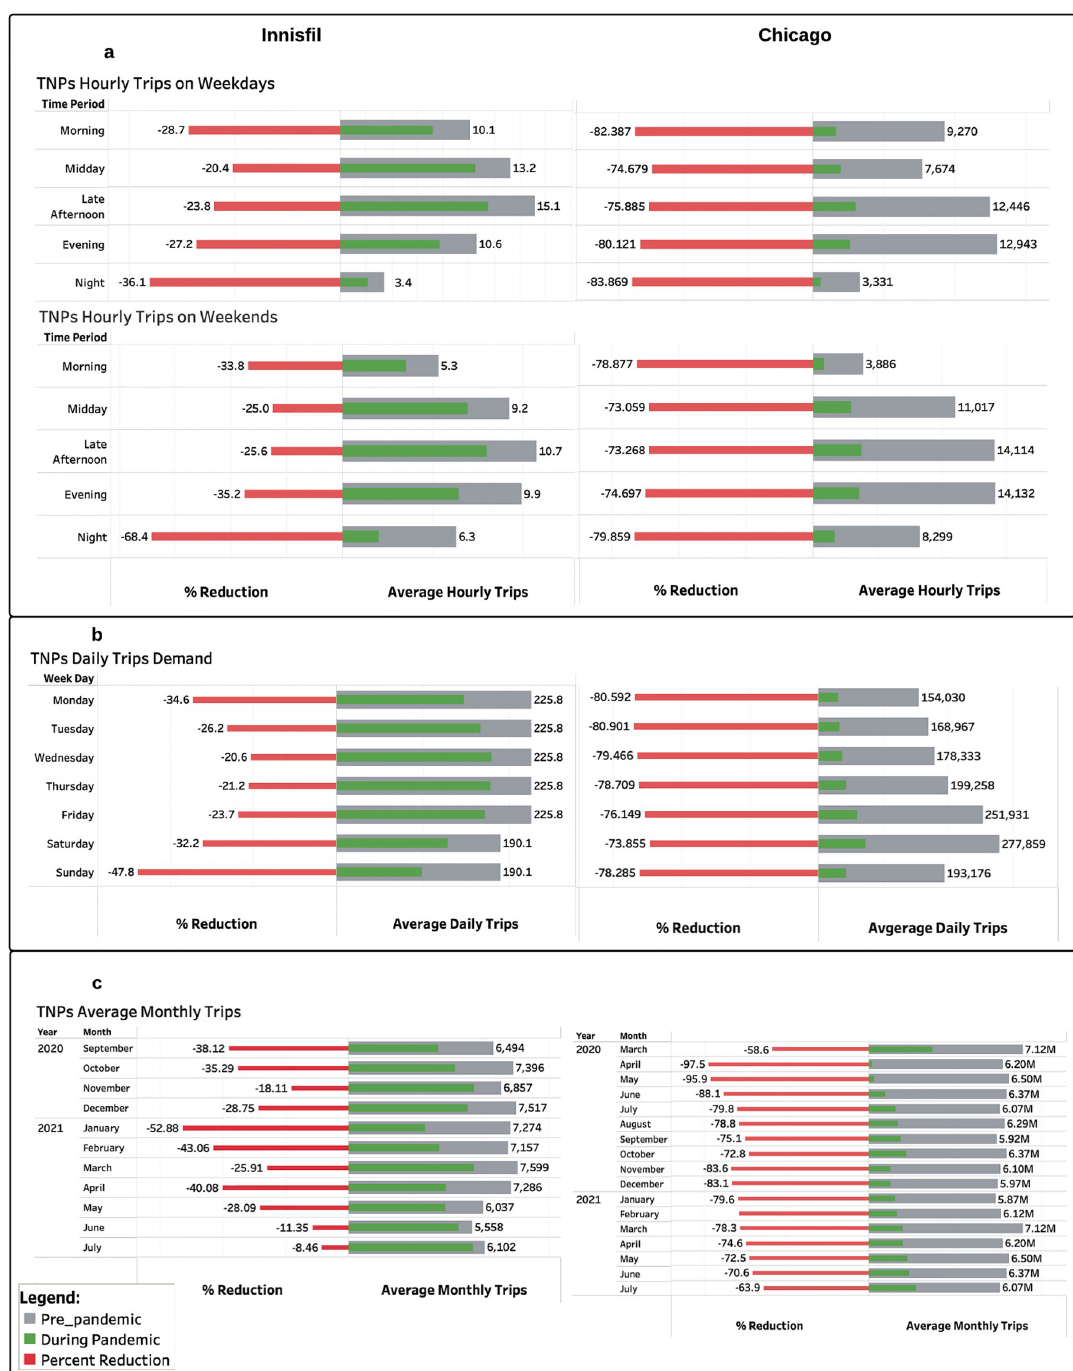
Fig 2. COVID-19 pandemic impacts on the temporal distribution of the demand for the ridesourcing services in the Town of Innisfil and the City of Chicago. (a) Hourly distribution of the demand pre and during the pandemic. (b) Daily distribution of demand pre and during the pandemic. (c) Monthly distribution of demand pre and during the pandemic.